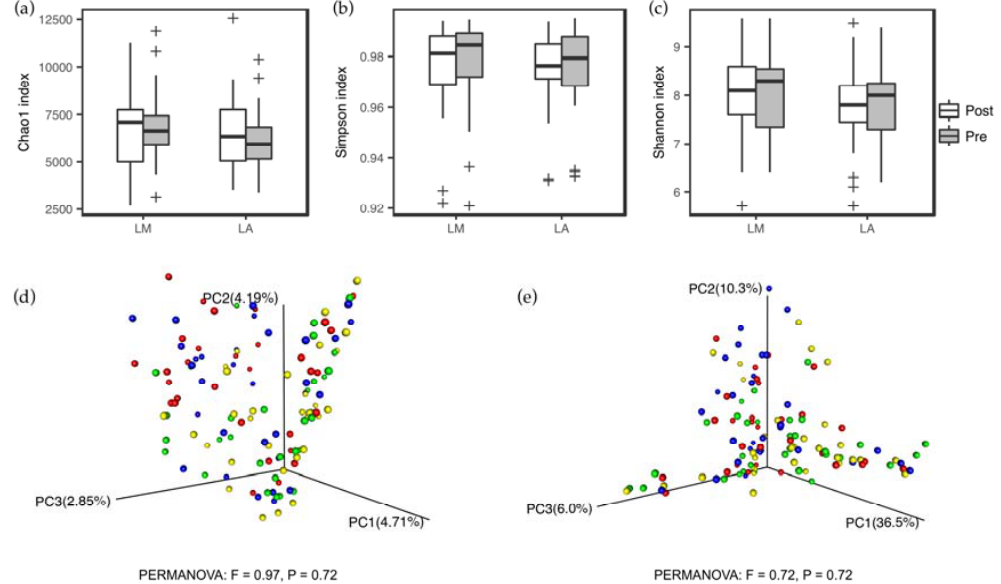
Figure 2. Gut microbiota diversity remained stable throughout the entire study. ( a – c ), α -Diversity, illustrated by Chao1 index ( a ), Simpson index ( b ), and Shannon index ( c ), of lactose malabsorbers (LM, n = 31) and absorbers (LA, n = 29). ( d , e ) Principal coordinate analysis based on unweighted ( d ) and weighted ( e ) UniFrac analysis of the microbiota communities in LA at baseline (red) and week 4 (blue), and LM at baseline (yellow) and week 4 (green). Box represents the interquartile range, the line inside represents the median, whiskers represent 10–90 percentiles, “+” represents outliers that are past the ends of the whiskers.